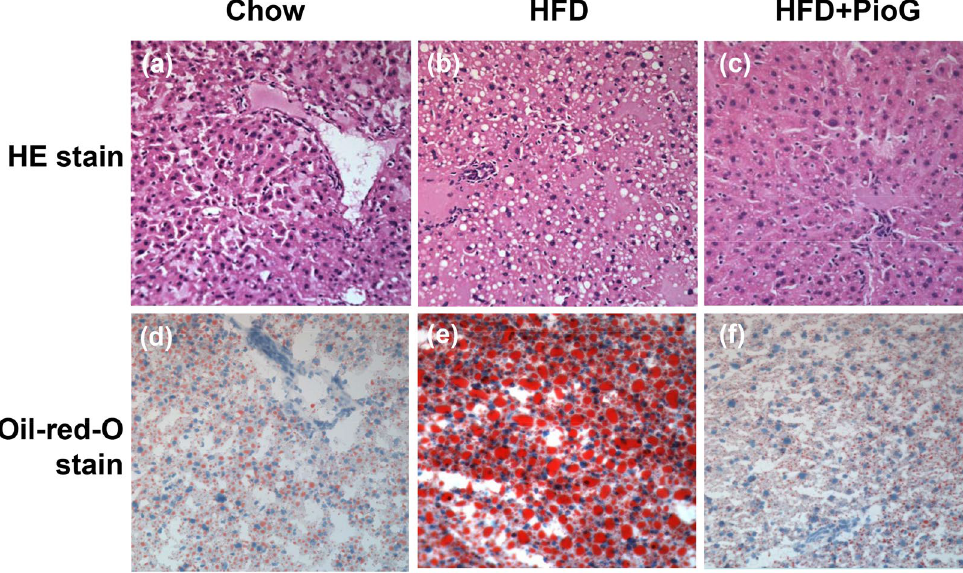
Figure 1. High fat diet-induced hepatic steatosis was attenuated by Pioglitazone. The liver specimens of mice, fed respectively with chow diet ( a , d ), high fat diet (HFD, b , e ), or high fat diet co-administered with pioglitazone (PioG, 100 mg/kg/d) ( c , f ) for 8 weeks, were applied for immunohistochemical staining by hematoxylin & eosin (H&E) and Oil-red O stain. Magnification: 400X.